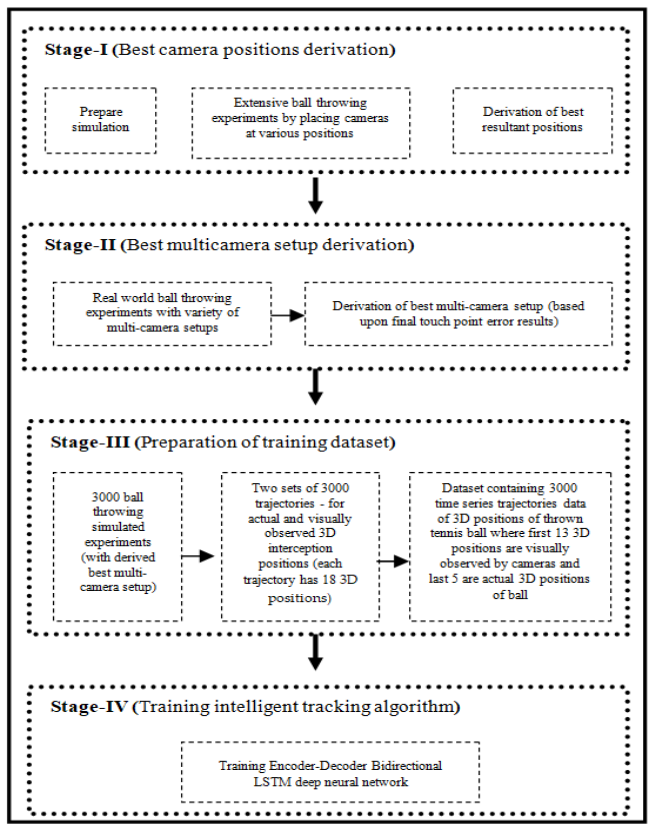
Figure 2. Proposed methodology.